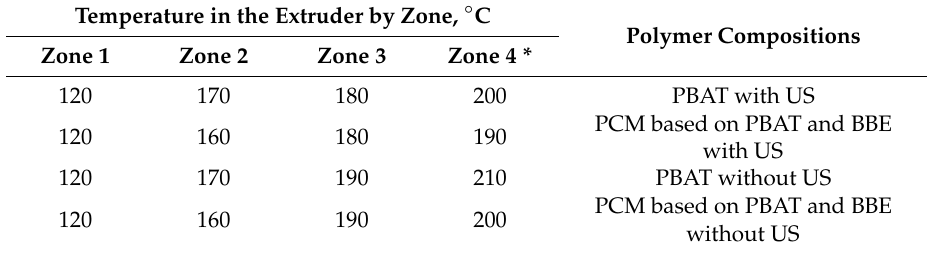
Table 1. Temperature conditions for processing polymer composite materials (PCM) granules in the extruder ( d = 16 mm).